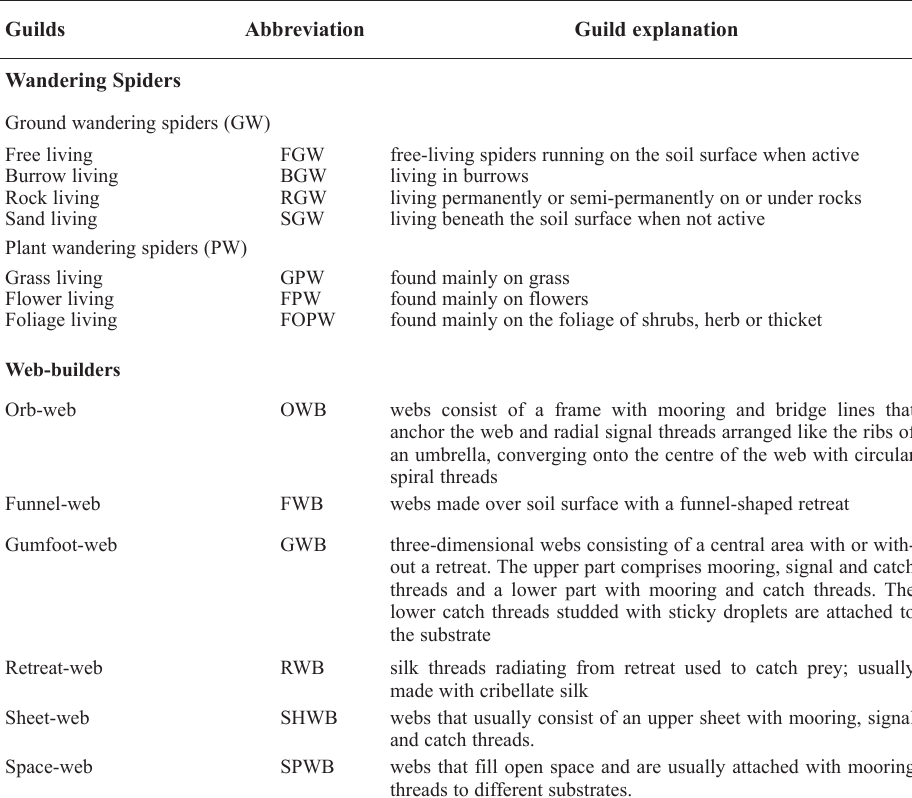
Table 1 Guild classification of spiders collected in the Mountain Zebra National